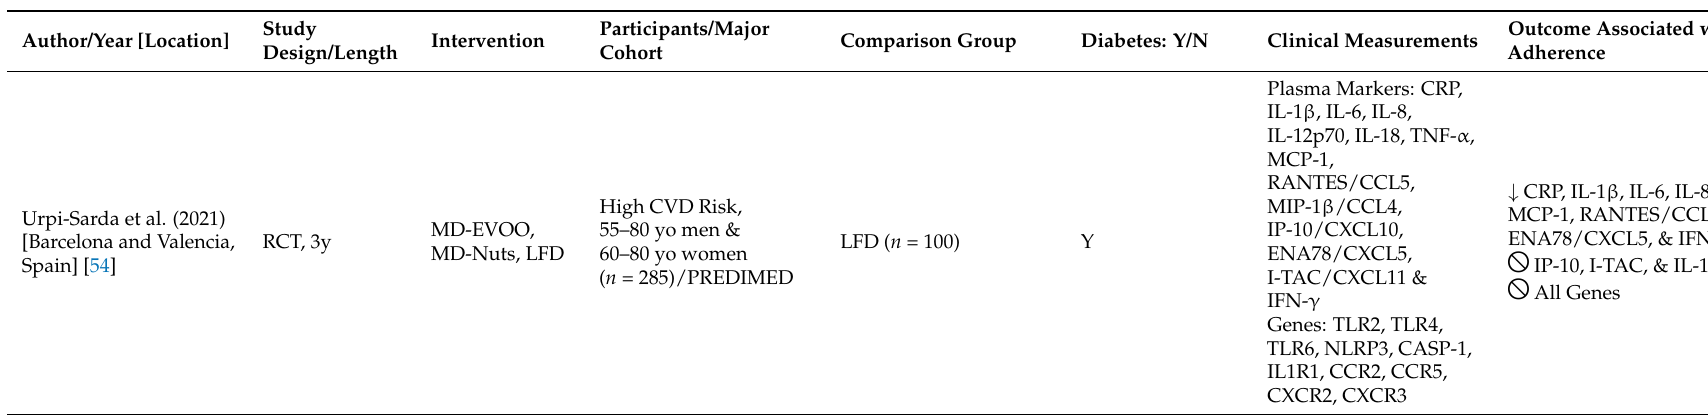
Table 2. Clinical Studies.